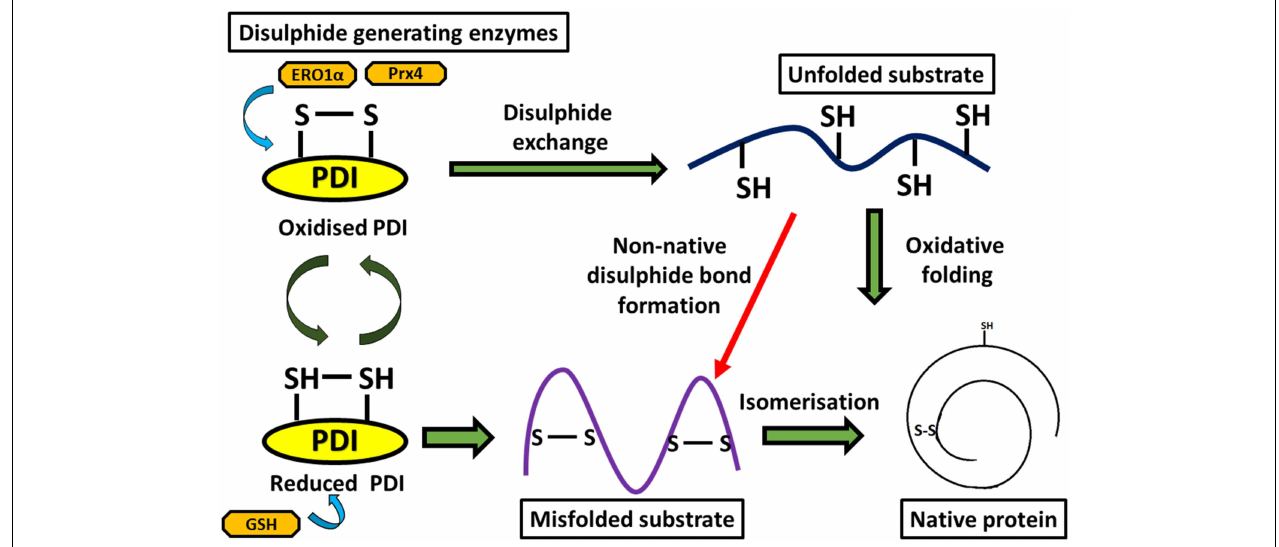
FIGURE 2 | Diagram representing disulphide bond formation in the eukaryotic ER and redox reactions involving PDI. Oxidative folding of PDI leads to disulphide bond formation in native protein substrates. Reduced PDI facilitates isomerization of non-native bonds in protein